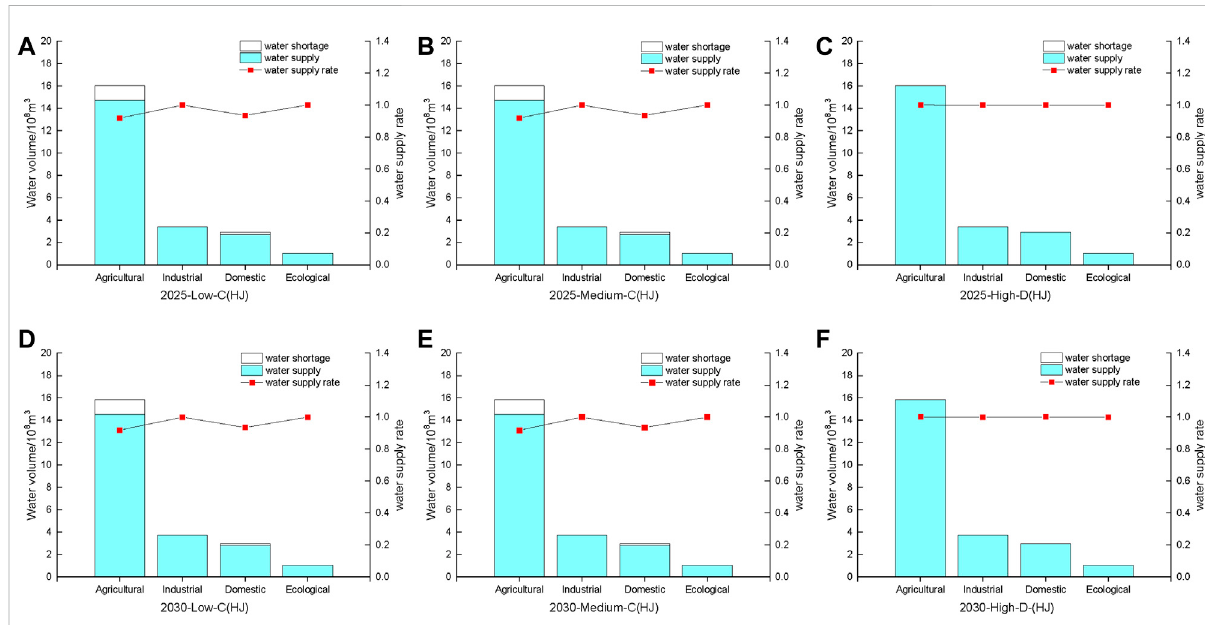
FIGURE 6 Distribution of water resources for six suitable scenarios in Huayuankou-Jiahetan section [ (A – F) represent 6 selected scenarios respectively].